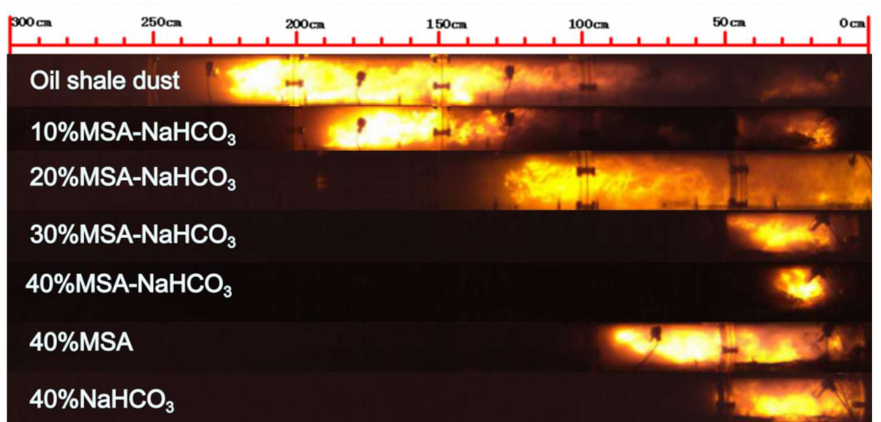
Figure 10. Flame suppression characteristics of explosion inhibitors for oil shale dust explosion in a semi-open